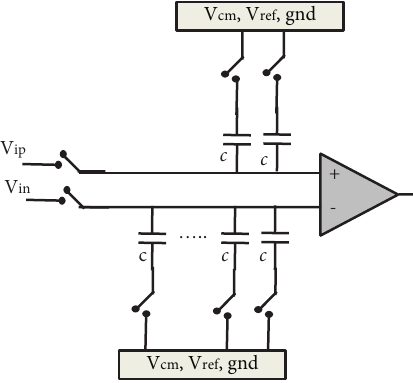
Figure 17: Te asymmetric